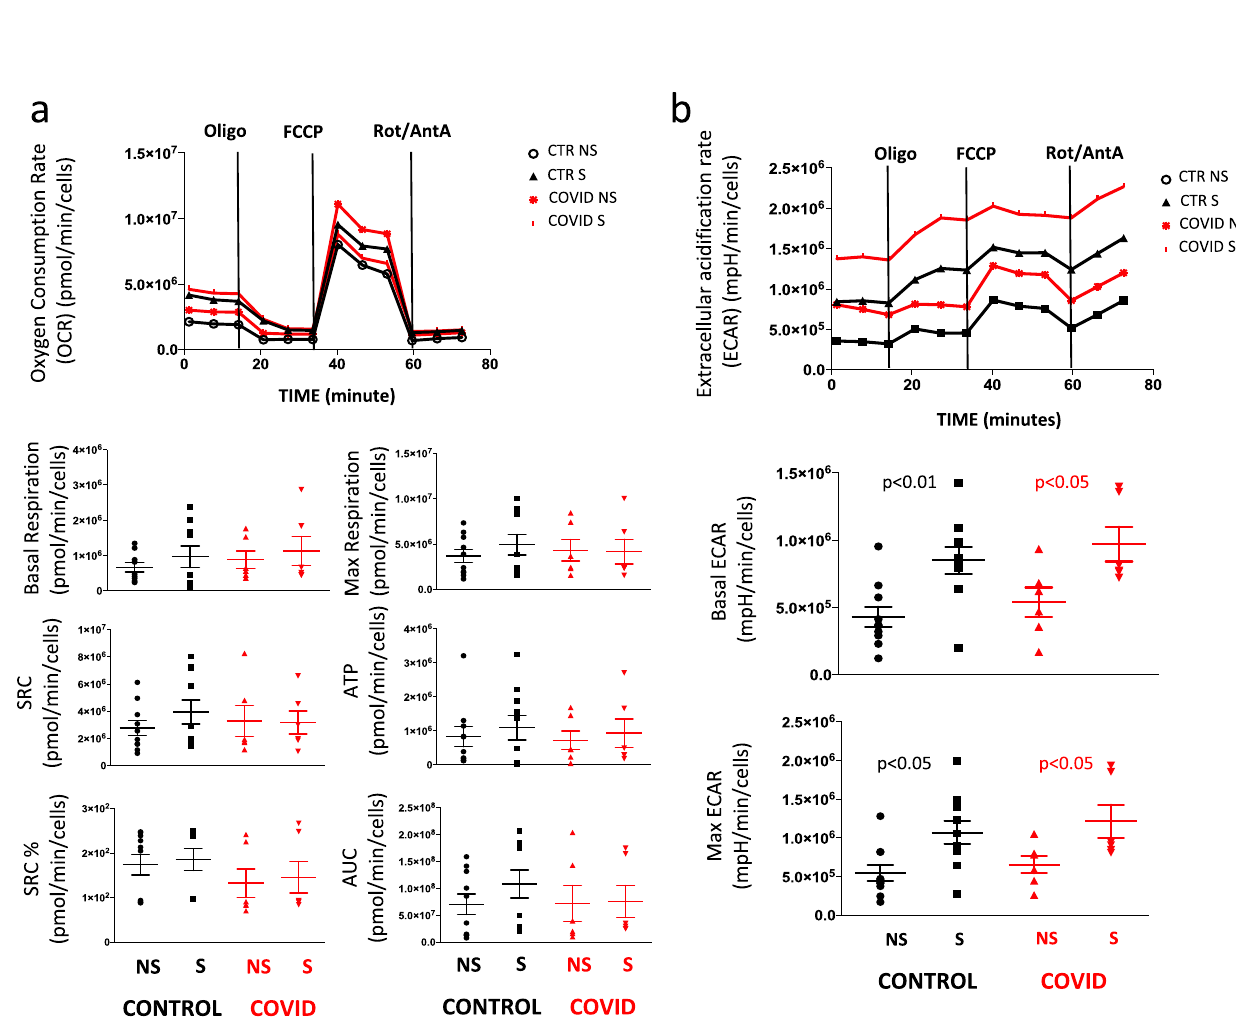
Fig. 6 Mitochondria bioenergetics of CD4 + T cells. a Representative traces (out of 12 experiments) of oxygen consumption rate (OCR) of unstimulated (NS) and stimulated (S) CD4 + T cells from healthy controls (CTR; n = 7) and COVID patients ( n = 5). OCR was measured in real time, under basal condition and in response to indicated mitochondria inhibitors: oligomycin (Oligo, 2 μ M), cyanide-4-(tri fl uoromethoxy)phenylhydrazone (FCCP, 0.5 μ M), and antimycin A plus rotenone (Rot/AA, 0.5 μ M). Histograms show the quanti fi cation of basal respiration, maximal respiration, spare respiratory capacity (SRC), ATP-linked respiration (ATP), percentage of SRC, and area under the curve (AUC) in cell stimulated (S) with anti-CD3/28 or non-stimulated (NS) from controls and patients. The percentage of SRC represents the ratio between the seventh and the third measurement. AUC was obtained by analyzing the area under the curve from the sixth to the eleventh measurement. Data represent individual values (dots) from seven patients and fi ve controls, mean (centre bar) ± SEM (upper and lower bars). Statistical analysis by two-sided Mann – Whitney nonparametric test shows no statistical differences between controls and patients. b Representative traces (out of 12 experiments) of extracellular acidi fi cation rates (ECAR) of unstimulated (NS) and stimulated (S) CD4 + T cells from one healthy control (CTR) and one COVID patient. ECAR was measured under basal conditions and in response to FCCP. Data represent individual values from seven controls and fi ve patients, mean (centre bar) ± SEM (upper and lower bars) concerning the quanti fi cation of basal ECAR and maximal ECAR in cell stimulated (S) with anti-CD3/28 or non-stimulated (NS) from controls and patients. Statistical analysis by two-sided Mann – Whitney nonparametric test shows no statistical differences between controls and